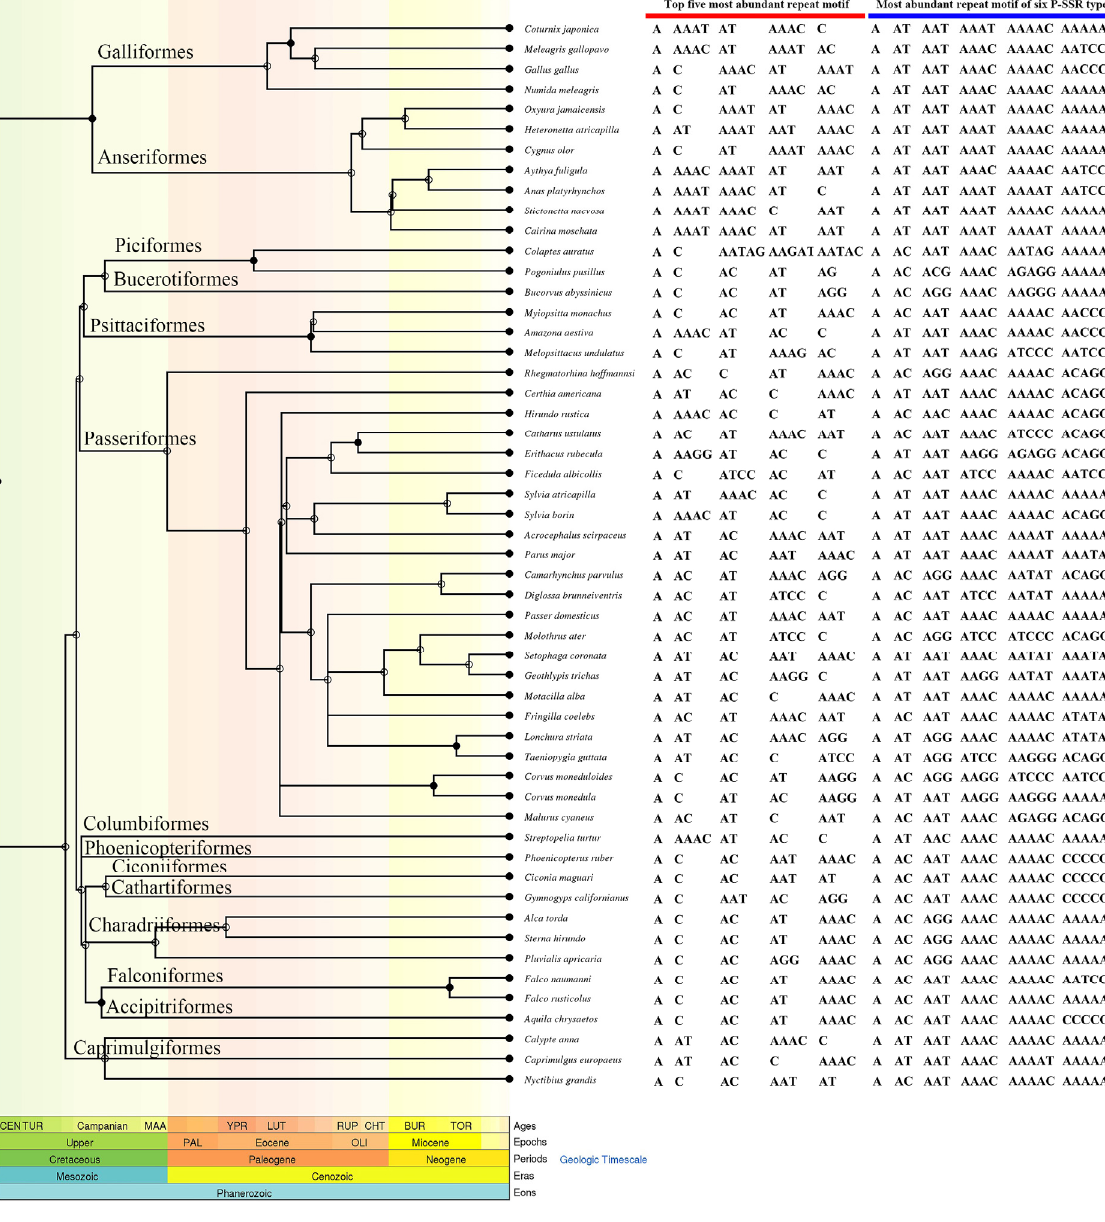
Figure 3. The repeat motifs preferences of P-SSRs.